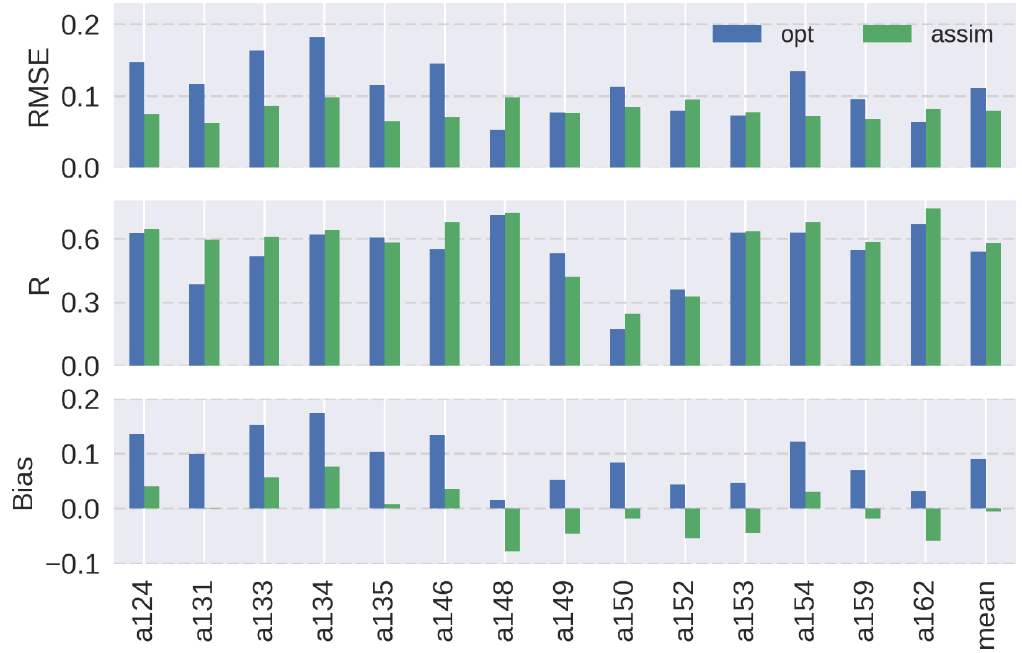
Figure 8. Summary of (top) the root-mean-square error (RMSE, m 3 m − 3 ), (middle) correlation coefficient (R), and (bottom) mean bias (m 3 m -3 ) for surface soil moisture at each observation site in Little Washita for the simulation starting on 6 February 2007. Blue and green bars show the results of the optimized model and assimilated model, respectively. Average values at all sites are shown on the left.